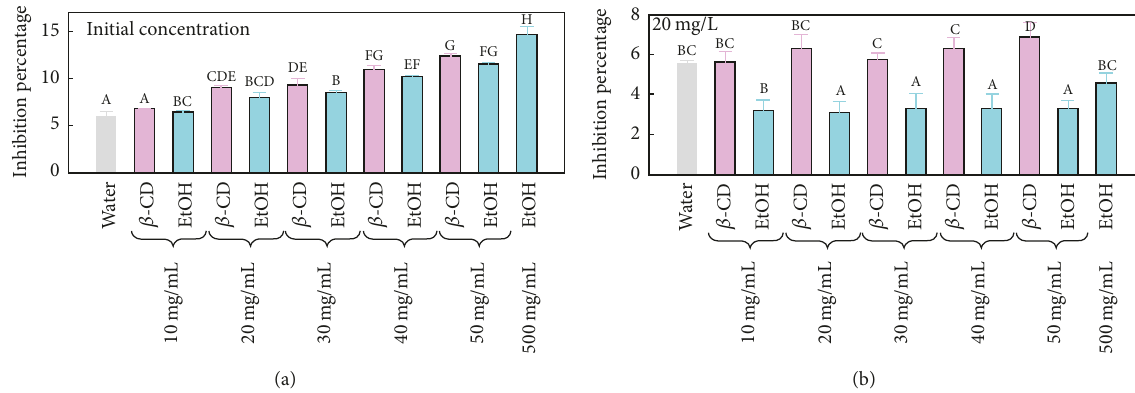
Figure 4: Comparison of the radical scavenging capacity of 𝛽 -CD and EtOH extracts (a) at their initial concentration and (b) at 20 mg/mL of polyphenols. Different superscript letters indicate significant statistical difference ( 𝑝 < 0.05